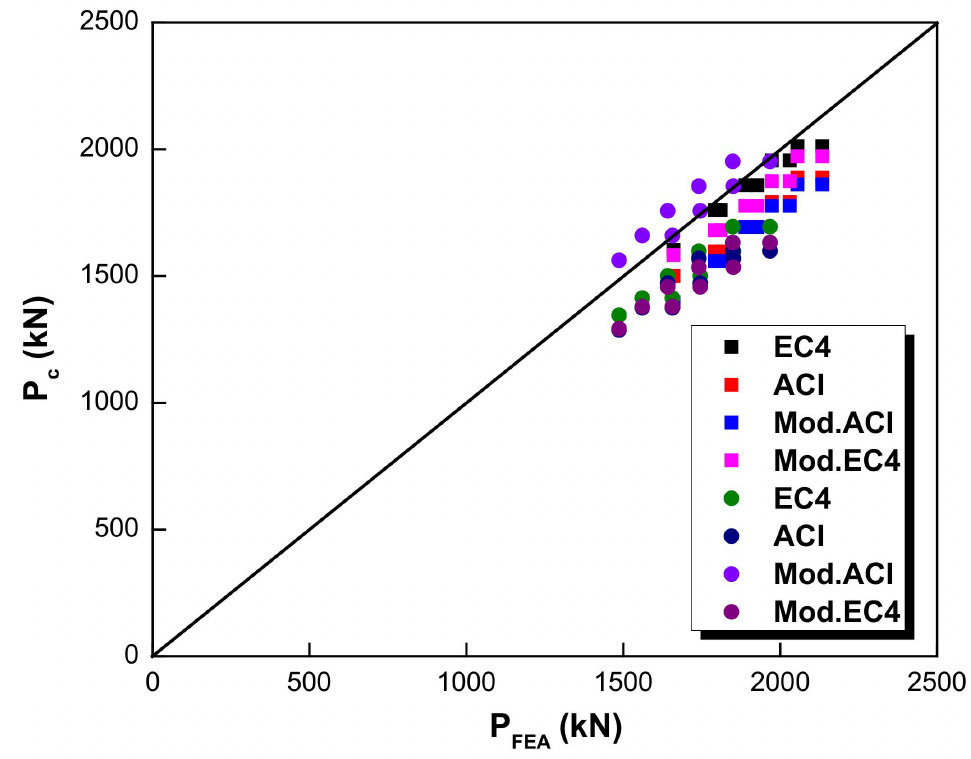
Figure 14. Comparison between results of FEA and